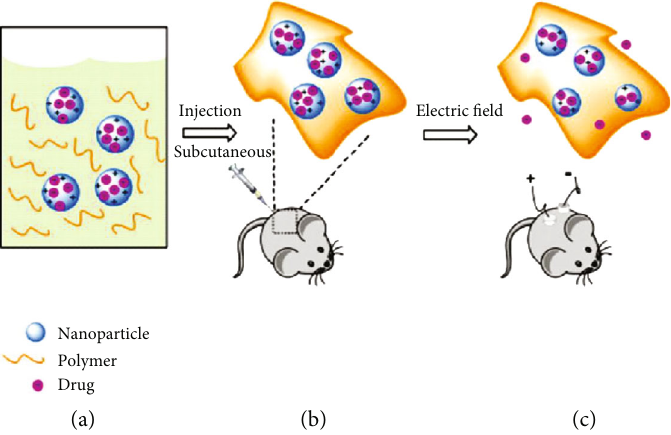
Figure 2: General scheme for the application of conducting polymer-hydrogel system. (a) The nanoparticle polymer solution is (b) subcutaneously injected into a mouse, followed by (c) application of a DC electric fi eld to induce release of the drug cargo inside the nanoparticles